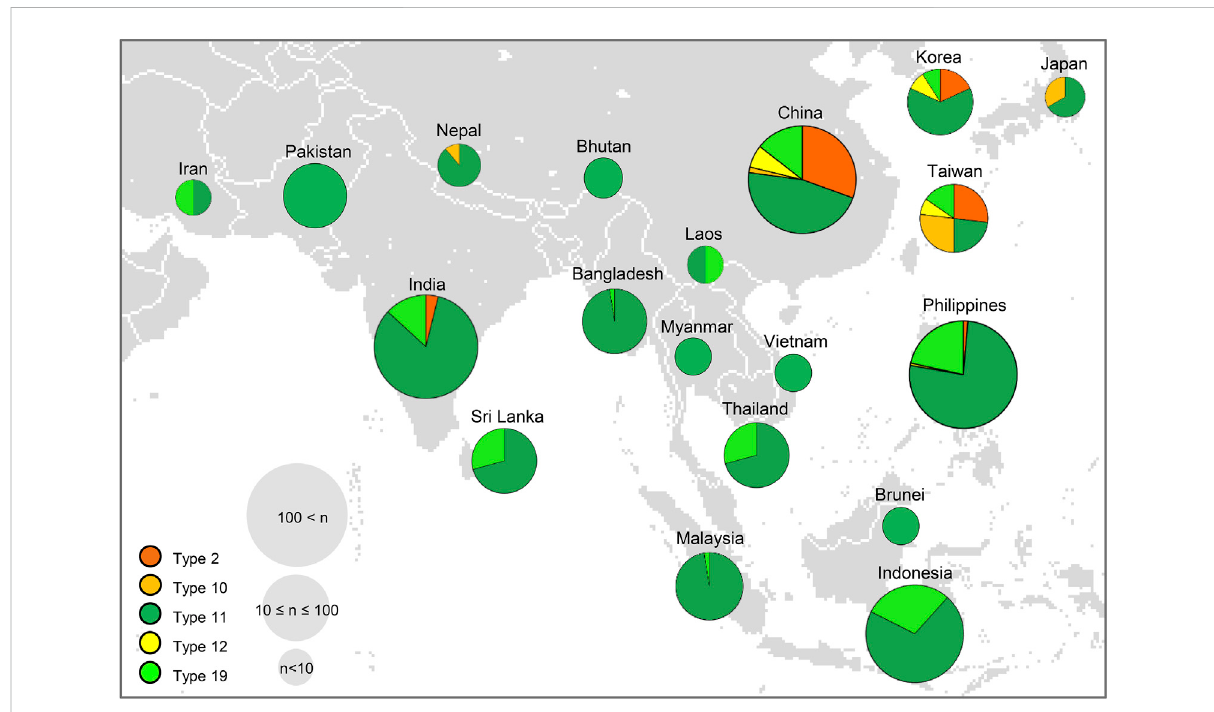
FIGURE 8 GeographicdistributionofcultivatedricevarietiesharboringdifferentalleliccombinationtypesofmajorHdgenesinAsia.Eachtypeisshownas different colors in the pie chart; Type 2 (orange), Type 10 (mustard), Type 11 (green), Type 12 (yellow), Type 19 (light green). The size of the circles represents the number of varieties in each country. In total, 3,000 rice varieties in the International Rice Genebank Collection Information System were used for allelic